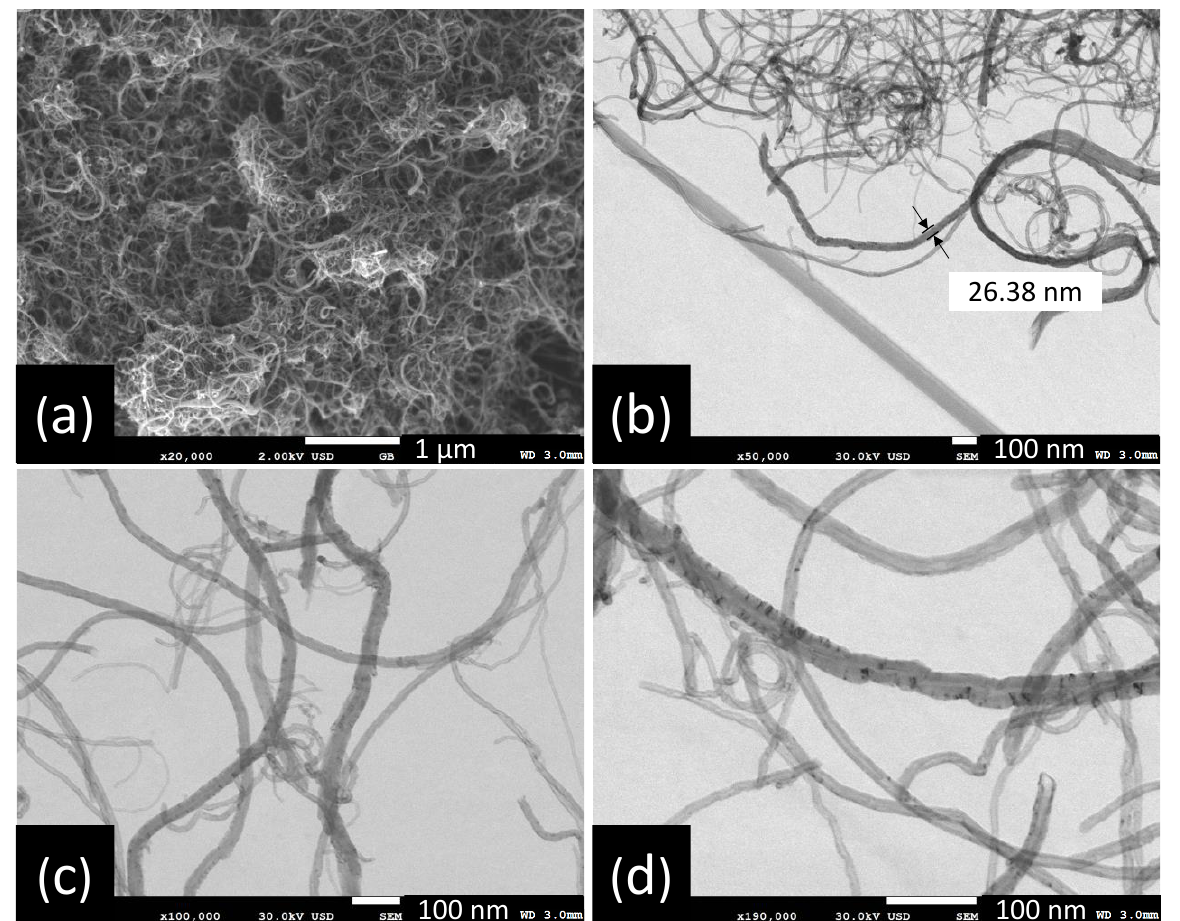
Figure 2. SEM micrographs of CNTs under different magnifications: ( a ) ×20,000; ( b ) ×50,000; ( c ) ×100,000 and ( d ) ×190,000.